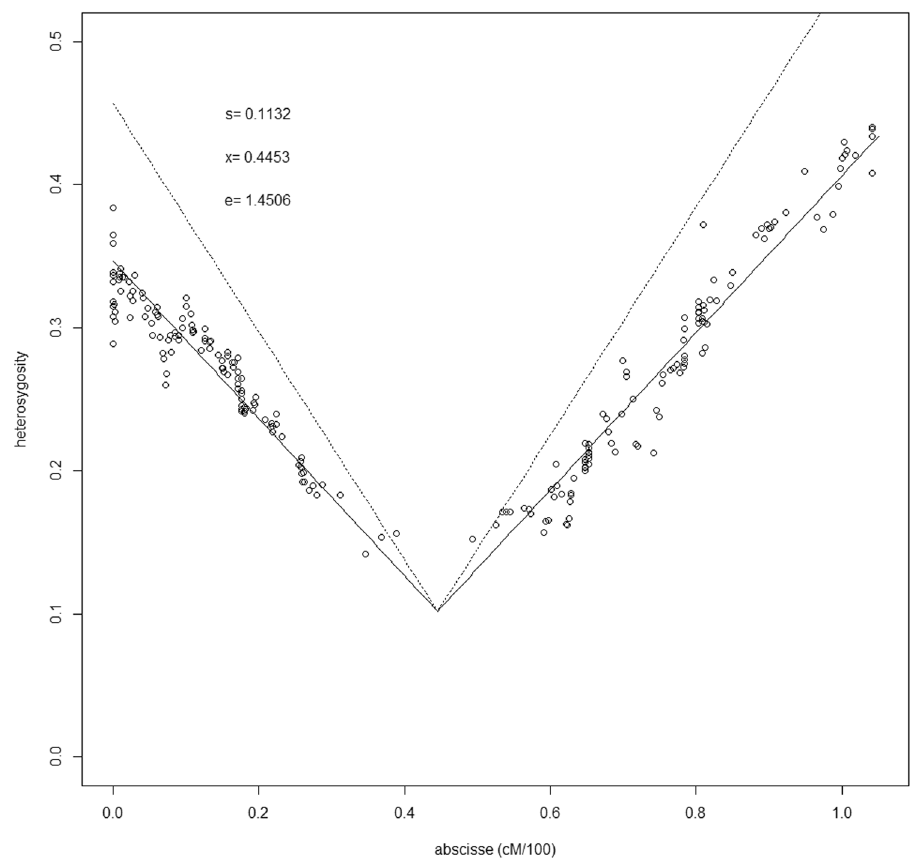
Fig. 2 Graphical estimation of the position of a locus under selection on LG Cn15. Each dot represents one locus. Expected variations of heterozygosity along the chromosome are modeled by the oblique lines (dotted lines, without genotyping errors correction, solid line, with error correction). s = fi tness of the heterozygote genotype; x = position of the selected locus; e = correction